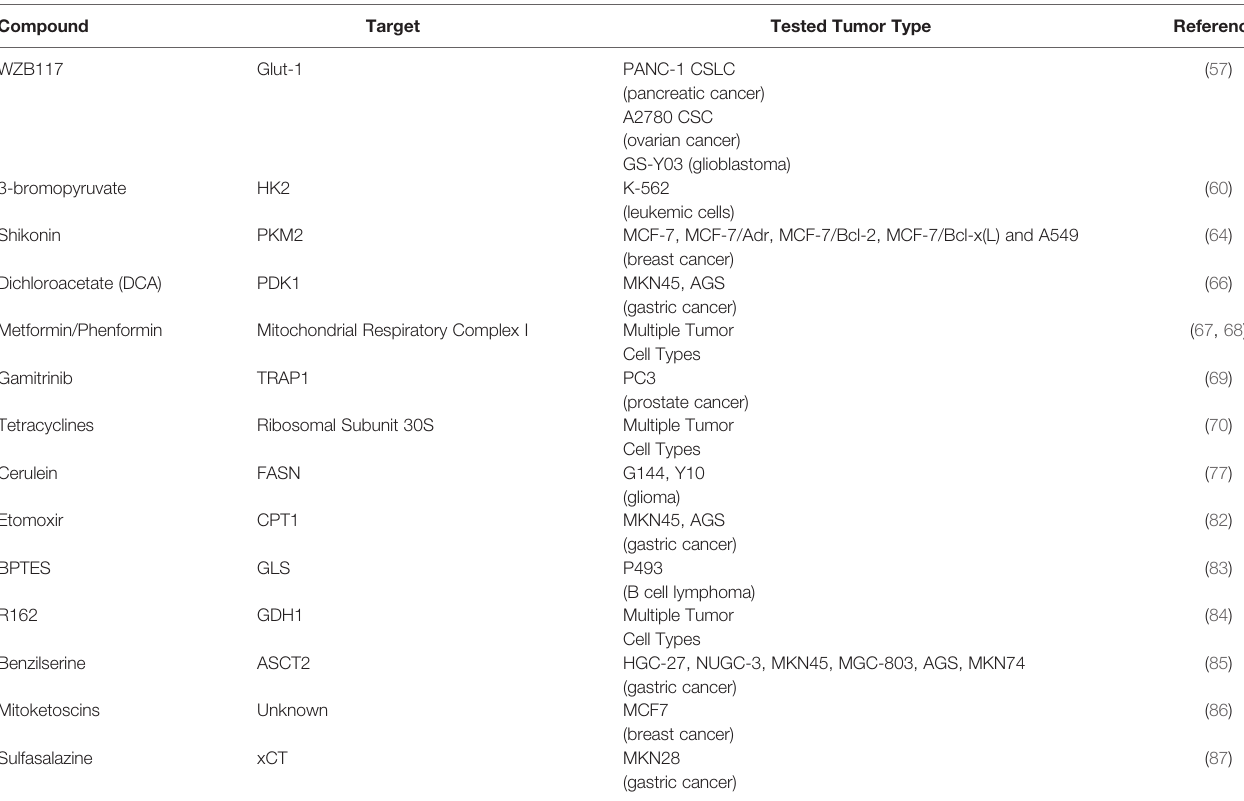
TABLE 1 | List of compounds targeting CSCs metabolism. Compound